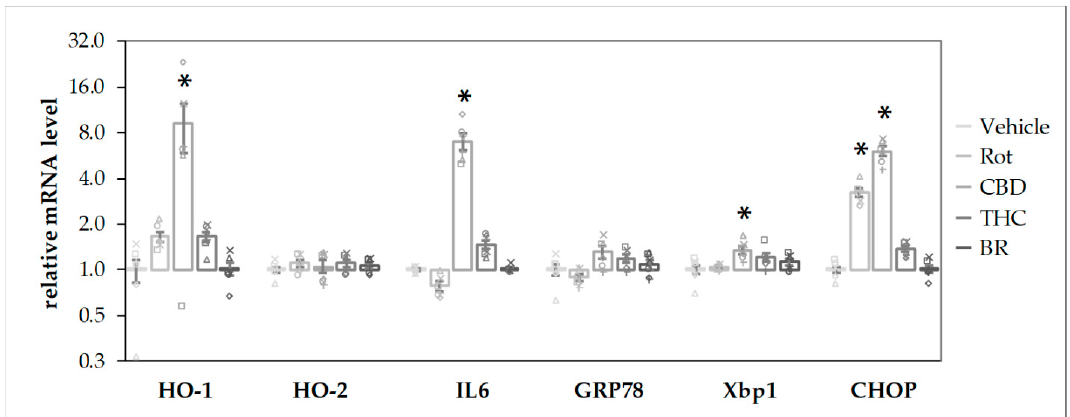
Figure 6. CBD and rotenone induce cellular stress responses in N18TG2 cells. N18TG2 cells were treated with vehicle (DMSO), rotenone (Rot; 80 nM), bilirubin (BR; 10 µ M), cannabidiol (CBD; 10 µ M), or tetrahydrocannabinol (THC; 10 µ M) for 16 h. Expression levels of mRNA for heme oxygenase 1 and 2 (HO-1; HO-2), interleukin 6 (IL6), glucose-regulated protein 78 (GRP78), X-box protein 1 (Xbp1), and C / EBP homologous protein (CHOP) were determined by quantitative reverse transcription PCR. Values were normalized to the internal reference gene Cyclophilin A, the obtained data were expressed relative to the respective control and are displayed on a logarithmic scale with the base of 2. Data are shown as both, individual values and mean ± SEM of six experiments ( n = 6) performed in duplicates. One-way ANOVA, followed by Bonferroni was performed to calculate significant di ff erences compared to the vehicle control and are indicated (* p < 0.05). Exact p values for the group comparisons are shown in the supplementary Table (Table S5).